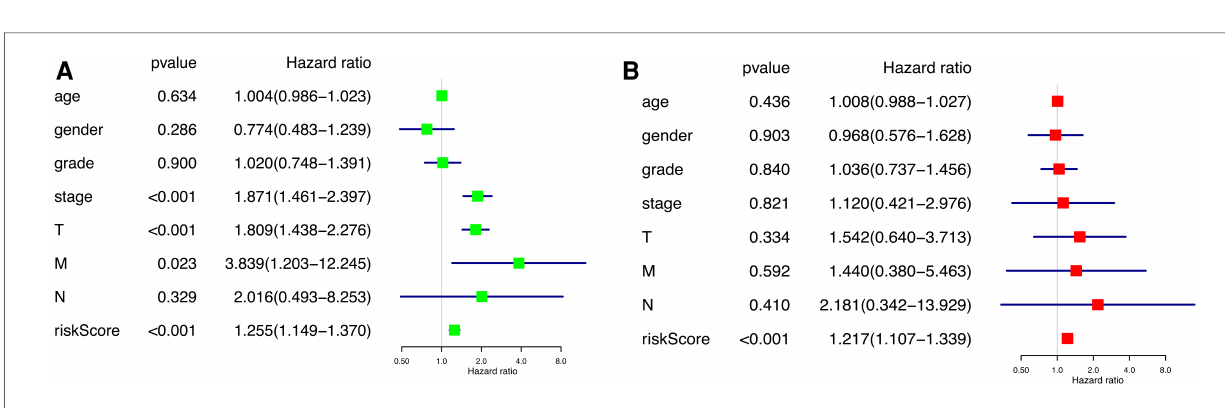
FIGURE 6 Independent prognostic analysis of prognostic model. ( A ) Univariate factor independent prognostic analysis. ( B ) Multivariate factor independent prognostic